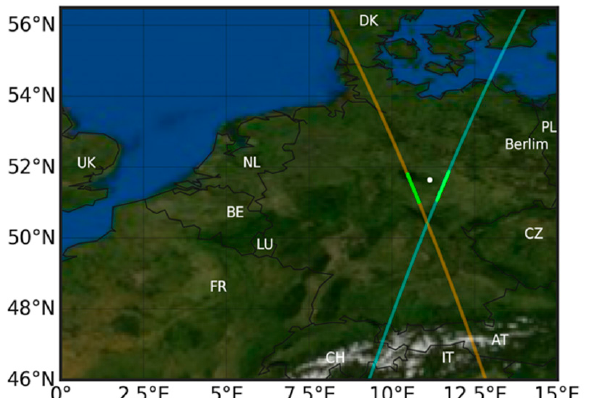
Figure 6. CALIOP orbit over Harzgerode: The blue line represents the CALIOP nighttime ground track for a cloud free case (06/08/14) at 01:39:59 UTC at 33.55 km distance, whereas the orange line represents the CALIOP daytime ground–track on a case with a thin cloud (04/05/16) at 12:20:44 UTC at 43.65 km distance from Harzgerode. The white dot represents the Harzgerode–DWD station. The green dots represent the CALIOP profiles that were averaged (5 km, 15 km, 25 km, 35 km, and 100 km) and compared to Harzgerode–DWD.